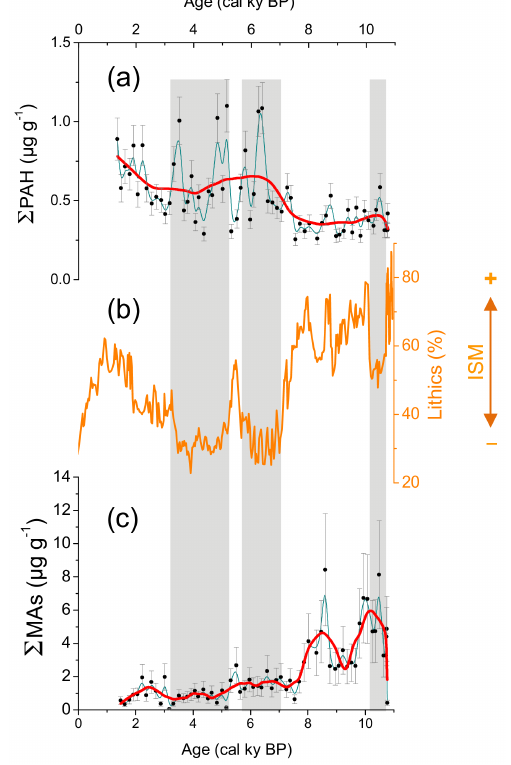
Figure 5. The response of combustion proxies to changes in ISM intensity in Paru Co. (a) Sum of PAH concentrations, data points (black) with absolute error range (grey), LOWESS smoothing with SPAN parameter 0.2 (red), b-spline interpolation (teal). (b) Lithics (%), data from Bird et al. (2014). (c) MA concentrations, data points (black) with absolute error range (grey), LOWESS smoothing with SPAN parameter 0.2 (red), b-spline interpolation